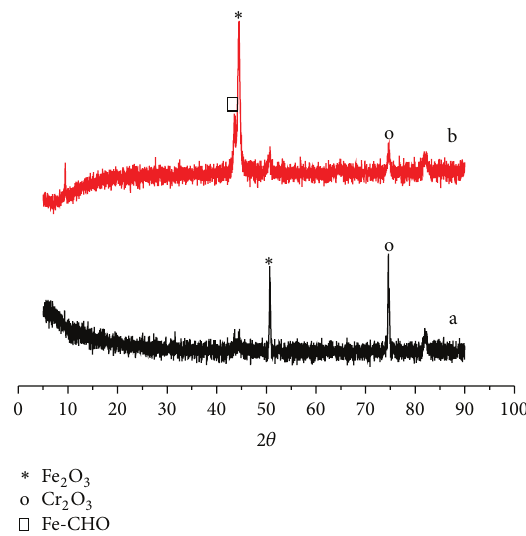
Figure 8: X-ray diffraction patterns of 304SS in 0.5 MH 2 SO 4 with- out (a) and with (b) inhibitor at temperature 298